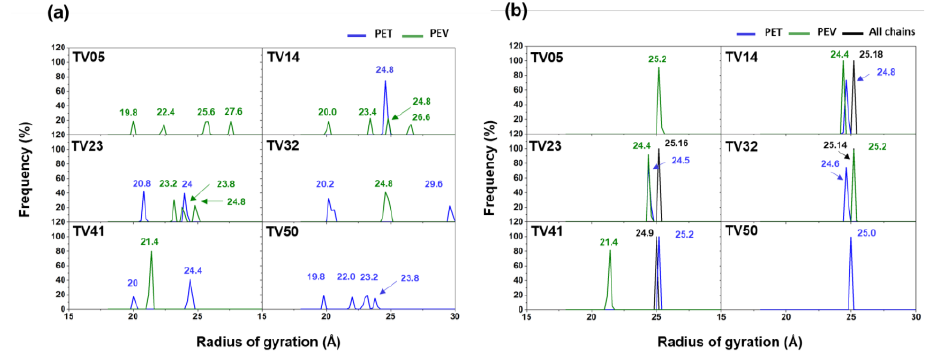
Figure 11. The radius of gyration of PET and PEV, and PET/PEV blends; ( a ) shows the distribution of R g of each five chains in the systems, while ( b ) shows the distribution of R g of each polymer type PET (blue), PEV (green), and all chains (black).